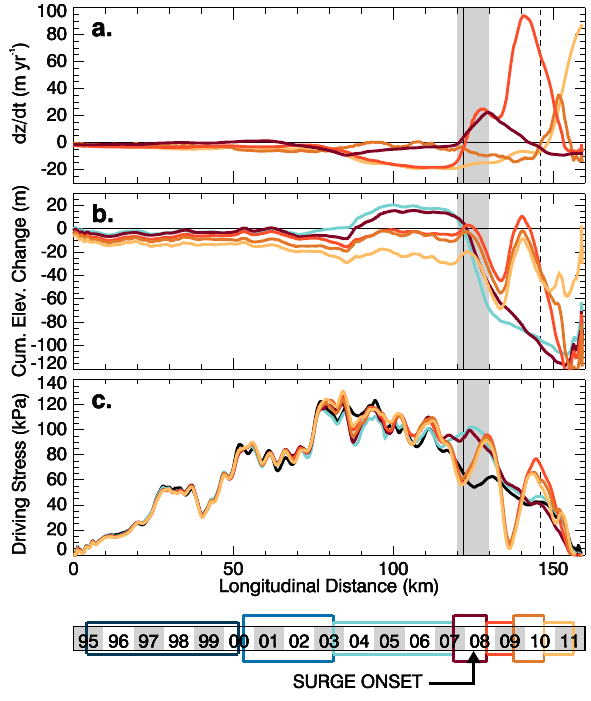
Fig. 6. Results from airborne altimetry on the BGS profile cont’d. Colors, intervals and notation represented as in Fig. 5. Dotted line represents DBL for the second stage. (a) Surface elevation change rate during the surge phase (same as Fig. 5d, provided for compar- ison). (b) Cumulative elevation change from 1995. Colors corre- spond to the surface profile at the end of each interval. (c) Calcu- lated driving stresses. Black line represents driving stress in 1995; colors correspond to the driving stress at the end of each